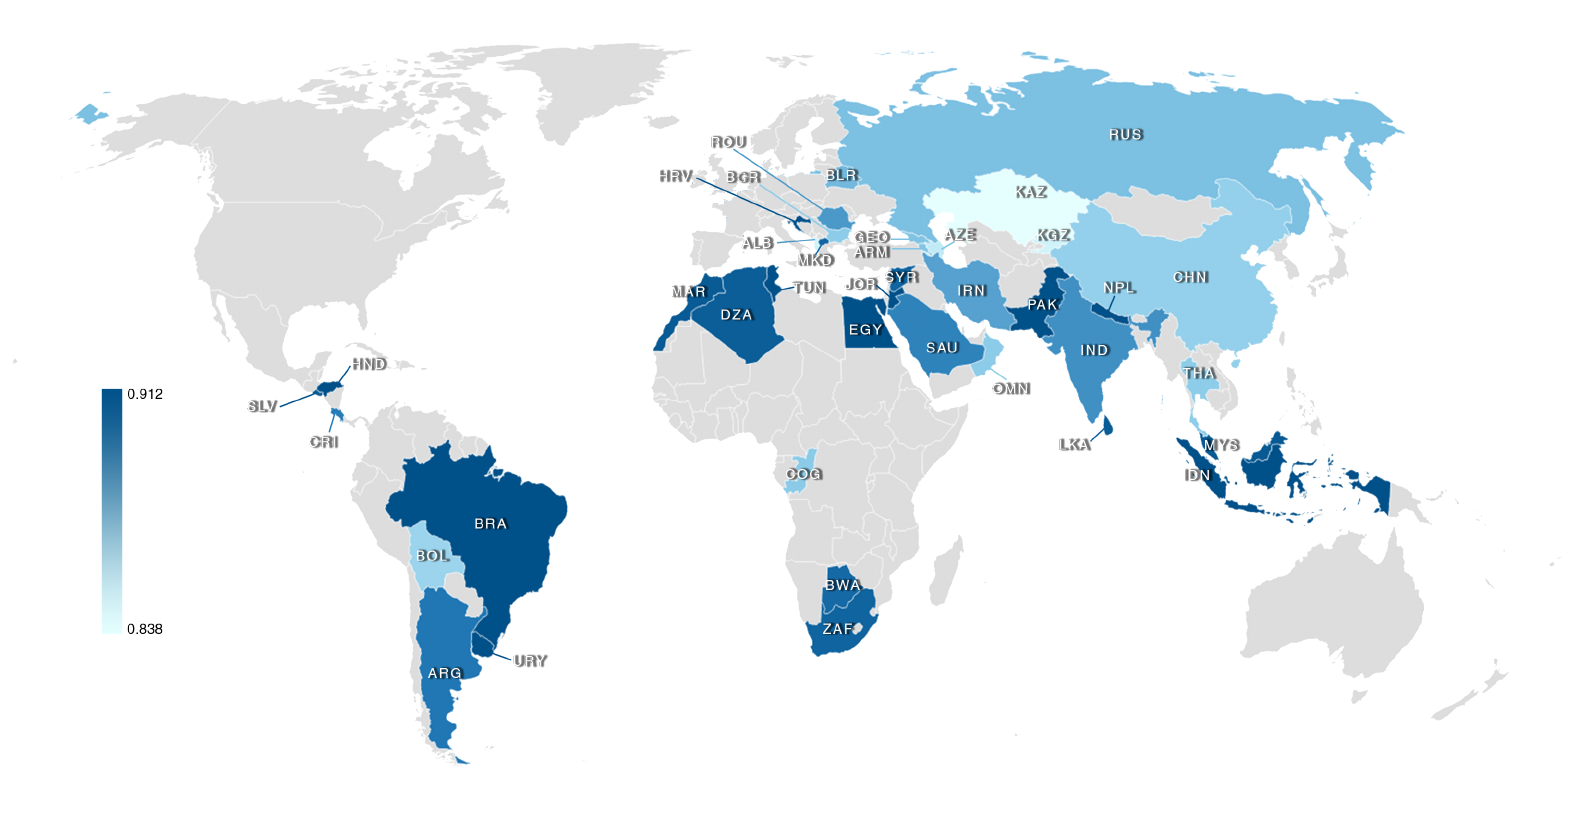
Figure 2. Energy efficiency in developing